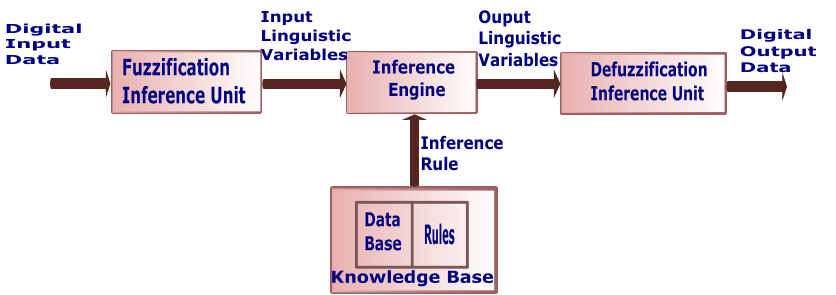
Figure 6. Block diagram of the fuzzy system.